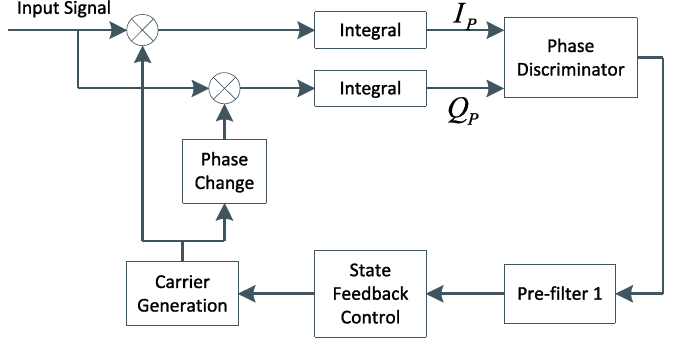
Figure 1. The carrier loop using pre-filter.